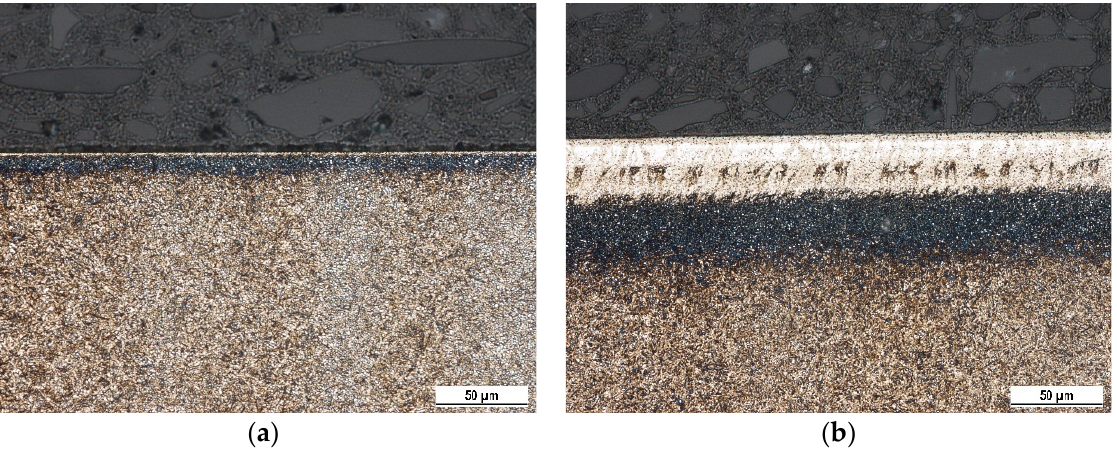
Figure 3. Metallographic images of hard-turned surfaces, v c = 100 m.min − 1 : ( a ) VB = 0.1 mm; ( b ) VB = 0.8 mm. Table 3. Thickness of WL as a function of cutting speed and flank wear VB (thickness of WL in μ m).